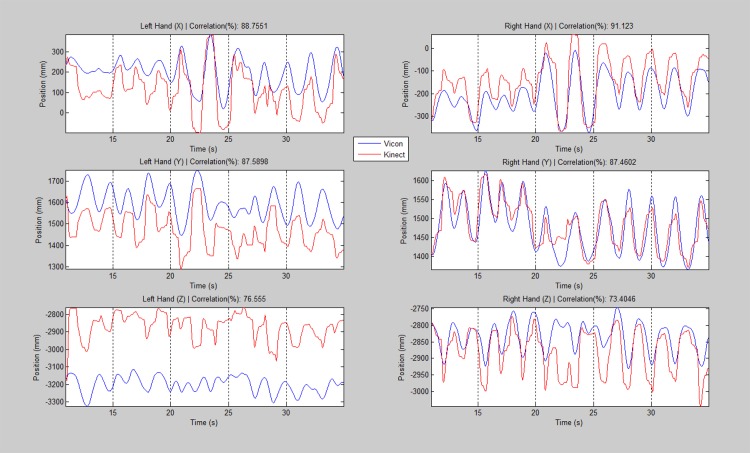
Correlation between Vicon and the NeuroKinect System.The average correlation for all 3 axes as 84.2%.